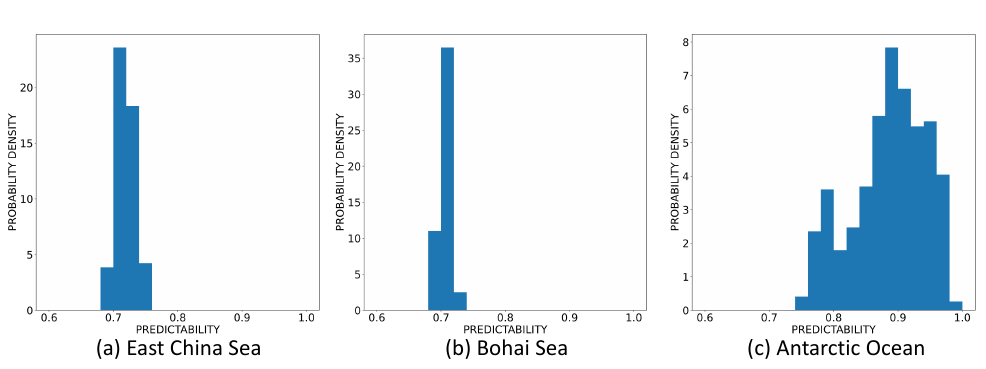
Figure 11. The probability distribution of the predictability of SST in the three sea areas.